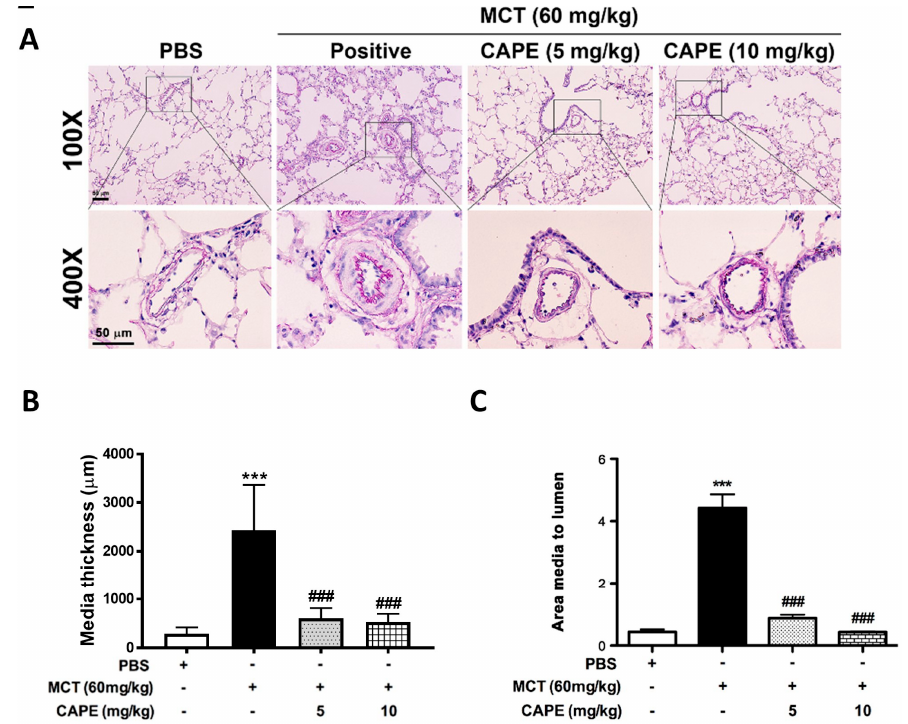
Figure 2. CAPE treatment reverses vascular remodeling in MCT-induced PAH rats. ( A ) Representative images of media hypertrophy in lung sections from the rats described in ( A ). Lung sections were stained for Elastic van Gieson (EvG). High magnification of images derived from the blocks is further displayed. Scale bars, 50 μ m. ( B , C ) The degree of vascular remodeling was evaluated by the pulmonary arterial wall thickness and the ratio of media thickness to lumen diameter using Image J analysis software. Values are means ± SEM. *** p < 0.01 vs. PBS group; ### p < 0.01 vs. MCT group. N = 10 independent images of arteries per group from five